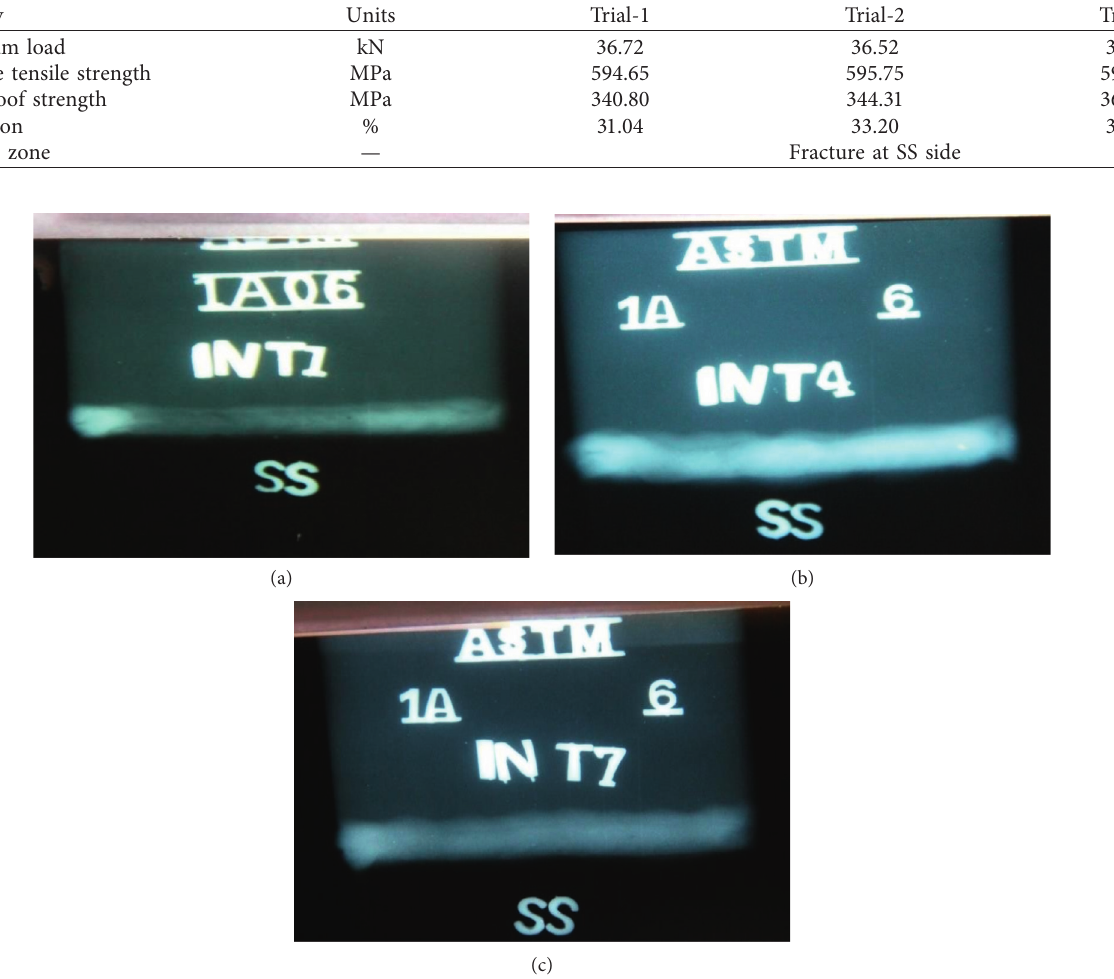
Figure 4: Radiography test of the weldments.